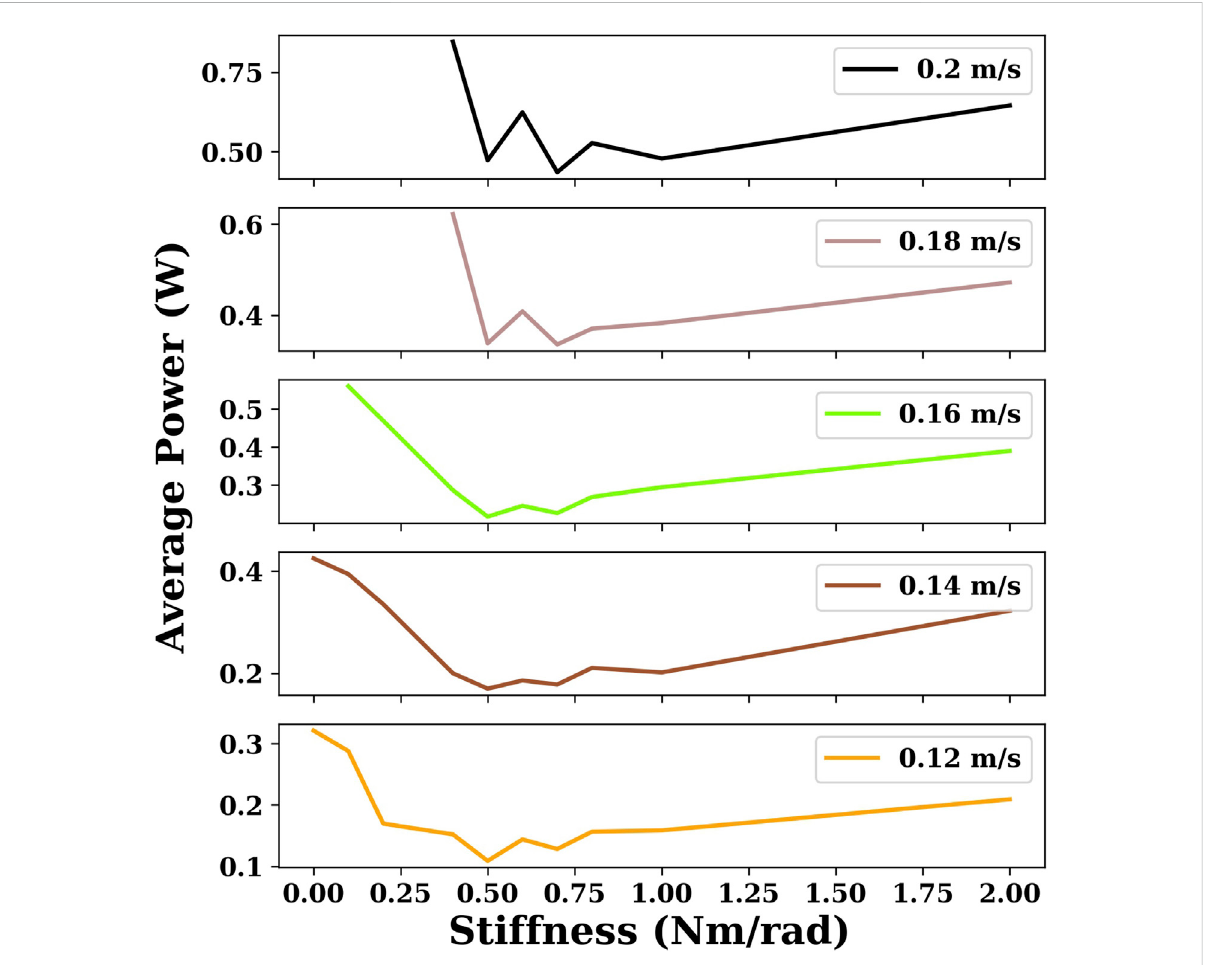
FIGURE 4 This plot indicates the minimum power consumption for the given velocities for snake robots with different joint stiffnesses using the gait equation controller. There are some cases of joint stiffness for which there are no sample points when the velocity is large because the maximum velocity of the snake robot is smaller than the given